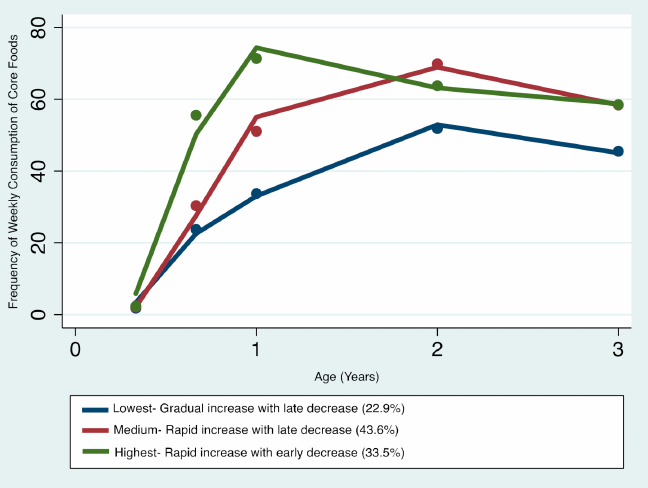
Figure 1. Trajectories of core foods consumption in infancy and early